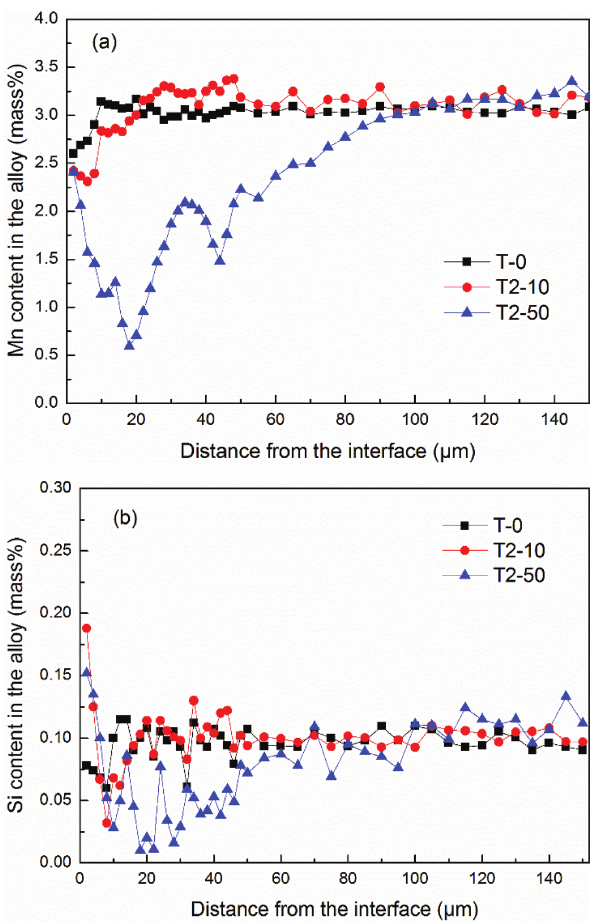
Figure 9: Variation of Mn and Si contents in the alloy near from the interface after heat treatment at